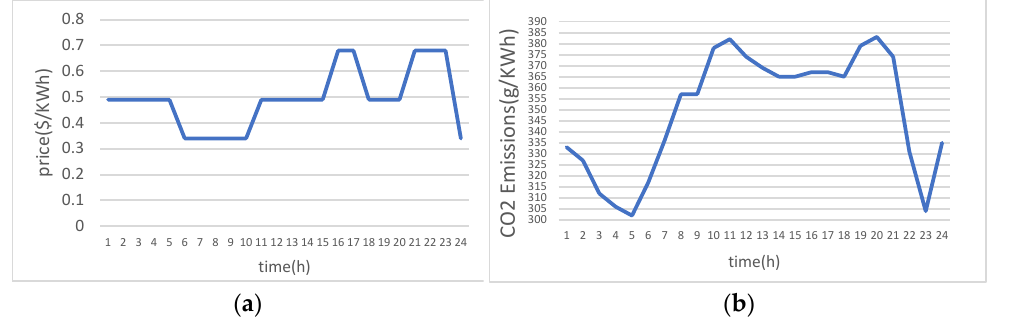
Figure 4. Electricity tariff ( a ) and CO 2 intensity ( b ). Table 1. Proposed energy hub parameters.